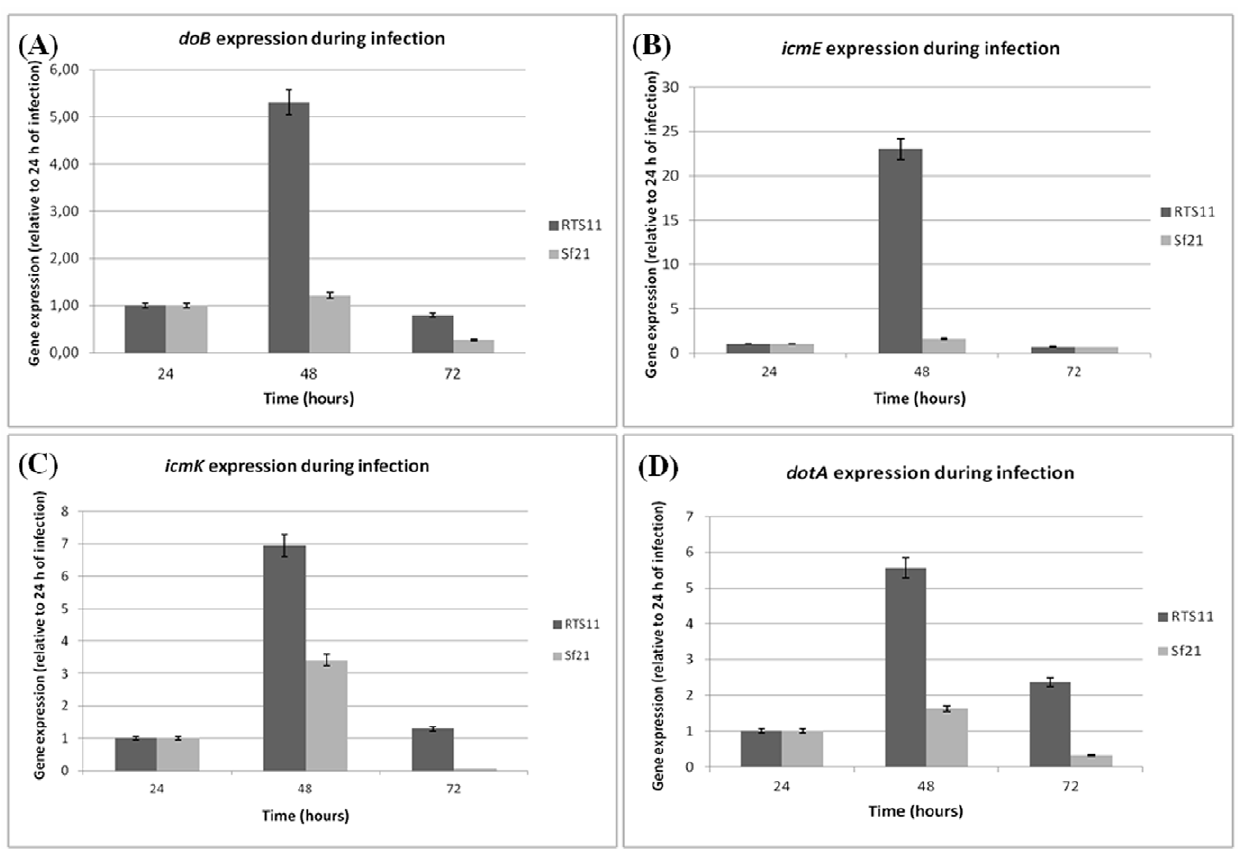
Figure 2. Expression profile of P.salmonisdot/icm genes during RTS11 and Sf21cell lines kinetic infection. Gene expression was determined by qRT-PCR, using relative quantification. A: dotB gene expression number; B: icmE gene expression; C: icmK mRNA gene expression; D: dotA gene expression. Gene expression was normalized by the use of ITS like a housekeeping gene. 24 hours post-infection in each cell line was used as calibrator (value=1).